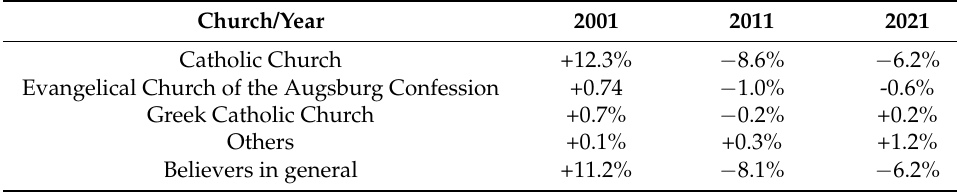
Table 3. Changes to the church’s declaration of membership.